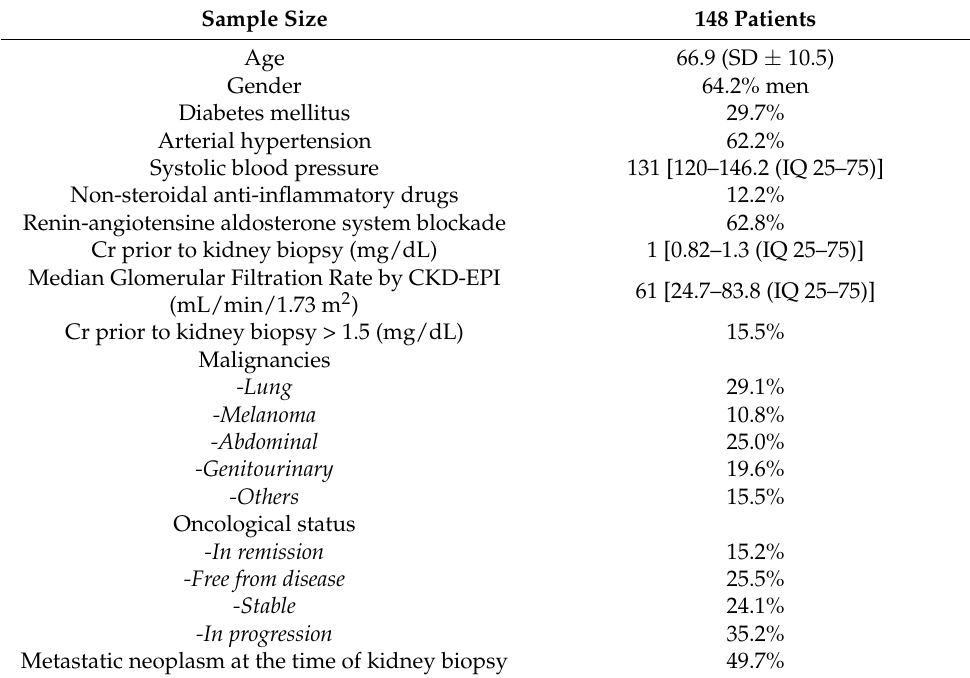
Table 1. Baseline characteristics of the studied